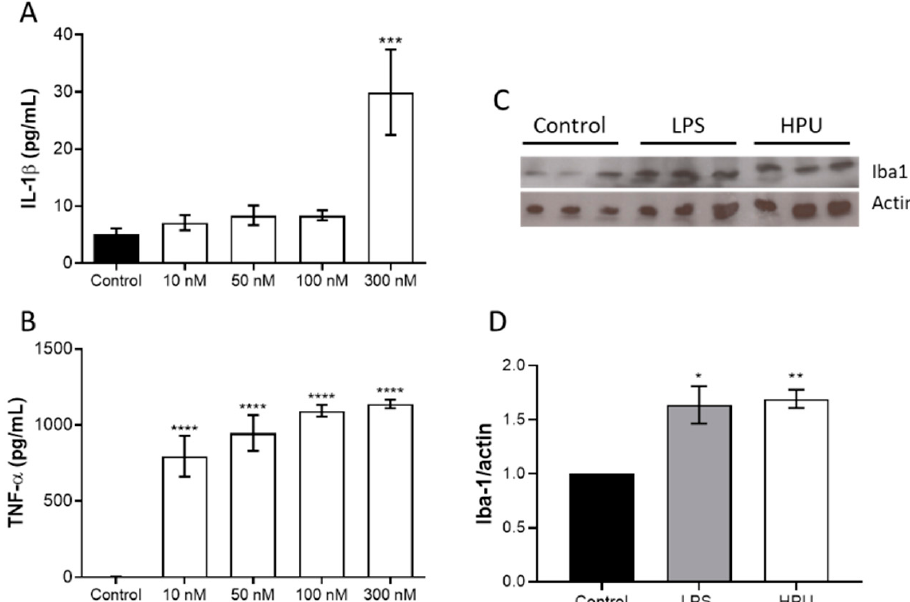
Figure 2. Toxicity of HPU to BV-2 cells ( A ) For ROS detection, BV-2 cells were incubated CM- DFFDA(2 mM) probe for 30 min, 37 °C, in the dark. After washing, BV-2 cells were incubated with 20 mM NaPB (control), or 50, 100 or 300 nM HPU for 6 h (gray columns) or 24 h (white columns). Fluorescence was measured at λ ex 495 nm/ λ em 527 nm. The results were expressed as a percentage of the control ± SEM and compared by one-way ANOVA followed by the Tukey test. * p < 0.05 vs. controls. ( B ) BV-2 viability was analyzed by the MTT test after 24 h of exposure to HPU. The cultures’ supernatants were removed after the treatments and cells were incubated with MTT (5 mg/mL) for 4 h at 37 °C, then suspended in 100 µL DMSO. Absorbances were read at 570 nm. Mean ± SEM. *** p < 0.001 vs. control.